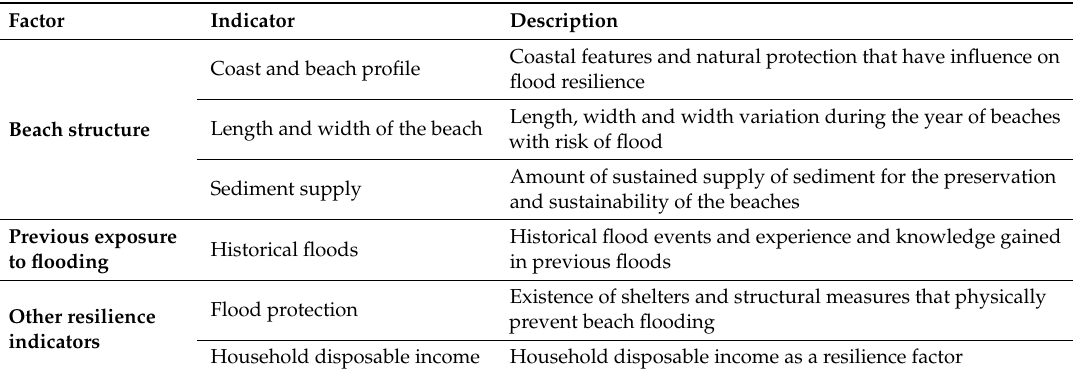
Table 4. Resilience